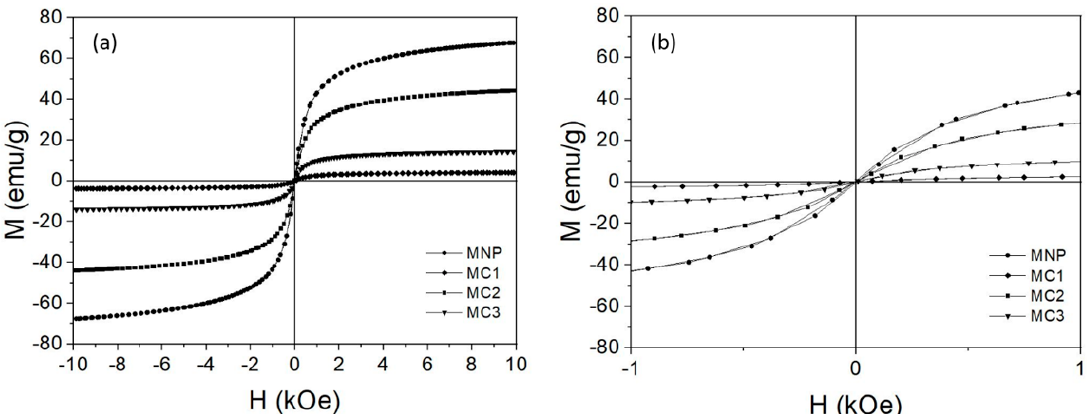
Figure 5. Magnetization curves of chitosan functionalized magnetic nanoparticles in comparison with bare magnetic nanoparticles; the filled circles represent magnetic maghemite nanoparticles (MNP), the filled inverted squares represent magnetic microparticles functionalized with chitosan using the microemulsion process (MC1), the filled squares represent magnetic microparticles functionalized with chitosan using the suspension cross-linking process (MC2), and the filled inverted triangles represent magnetic nanoparticles functionalized with chitosan using the covalent binding method (MC3), where ( a ) presents magnetization curves ranging from − 10 kOe to +10 kOe and ( b ) presents magnetization curves near zero magnetic field ranging from − 1 kOe to +1 kOe.